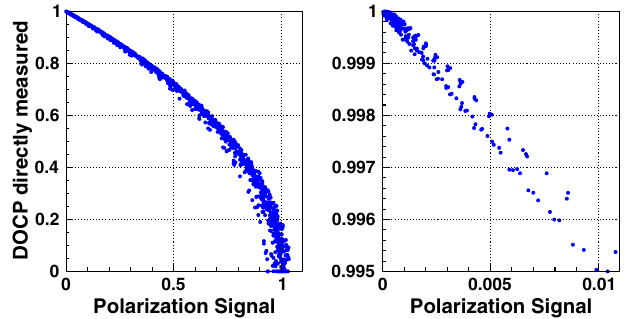
FIG. 6. (Top panel) Typical Monte Carlo simulated Compton spectra for a single detector plane; ideal (black open circles), with noise (red), and with detector efficiency (blue, shaded). (Bottom panel) The Compton asymmetry extracted from the simulated spectrum including detector efficiency (blue circles), and a two- parameter fit to the calculated asymmetry (red line). The input asymmetry was